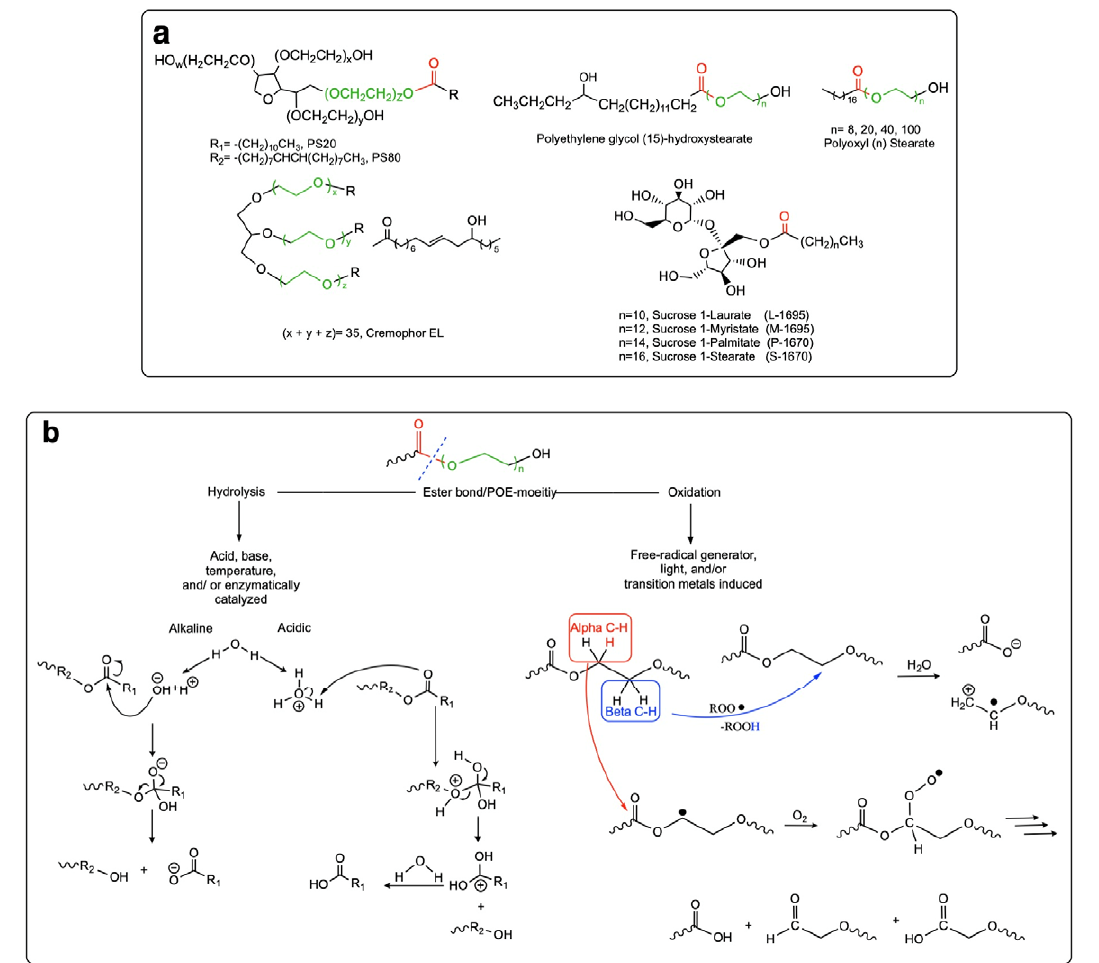
Figure 1. ( a ) Idealized chemical structure of PSs and potential surfactant alternatives containing ester bonds. The ester bonds are highlighted in red, and the POE moiety in green; ( b ) Expected degradation mechanisms for ester bond/POE-containing surfactants [65].